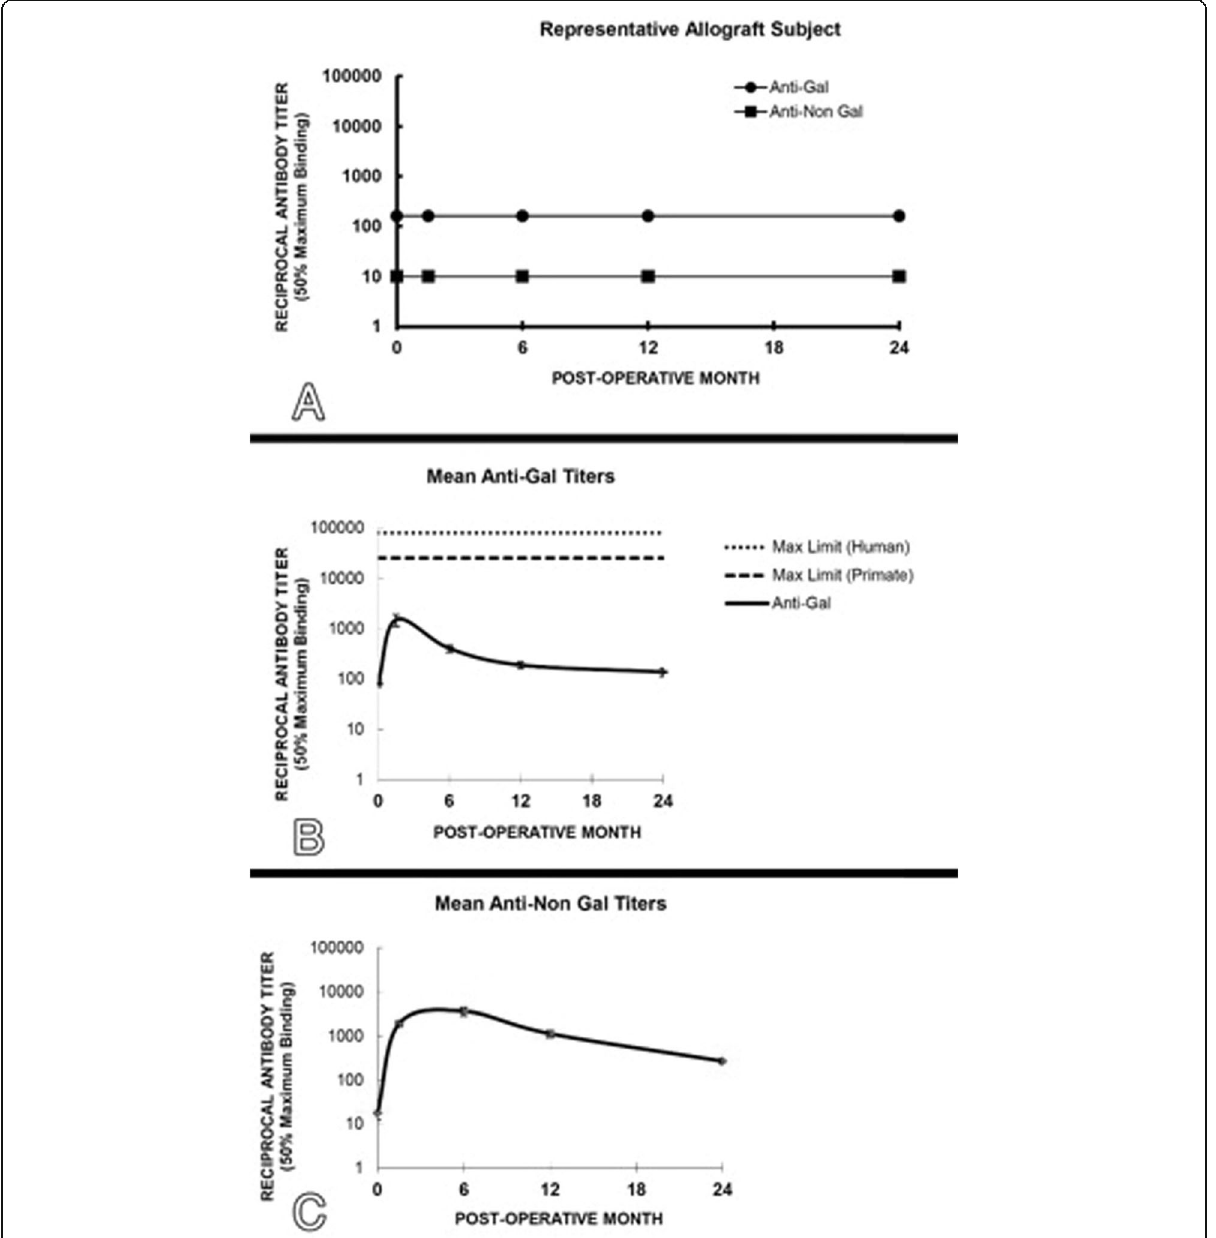
Fig. 6 anti-Gal and anti-non Gal antibody testing results in a representative allograft patient ( a ), mean anti-Gal titers (± standard error) for the patients implanted with the xenograft device ( b ) and the anti-non Gal antibody response against the multiple immunogenic porcine proteins within the xenograft ( c ). See text for